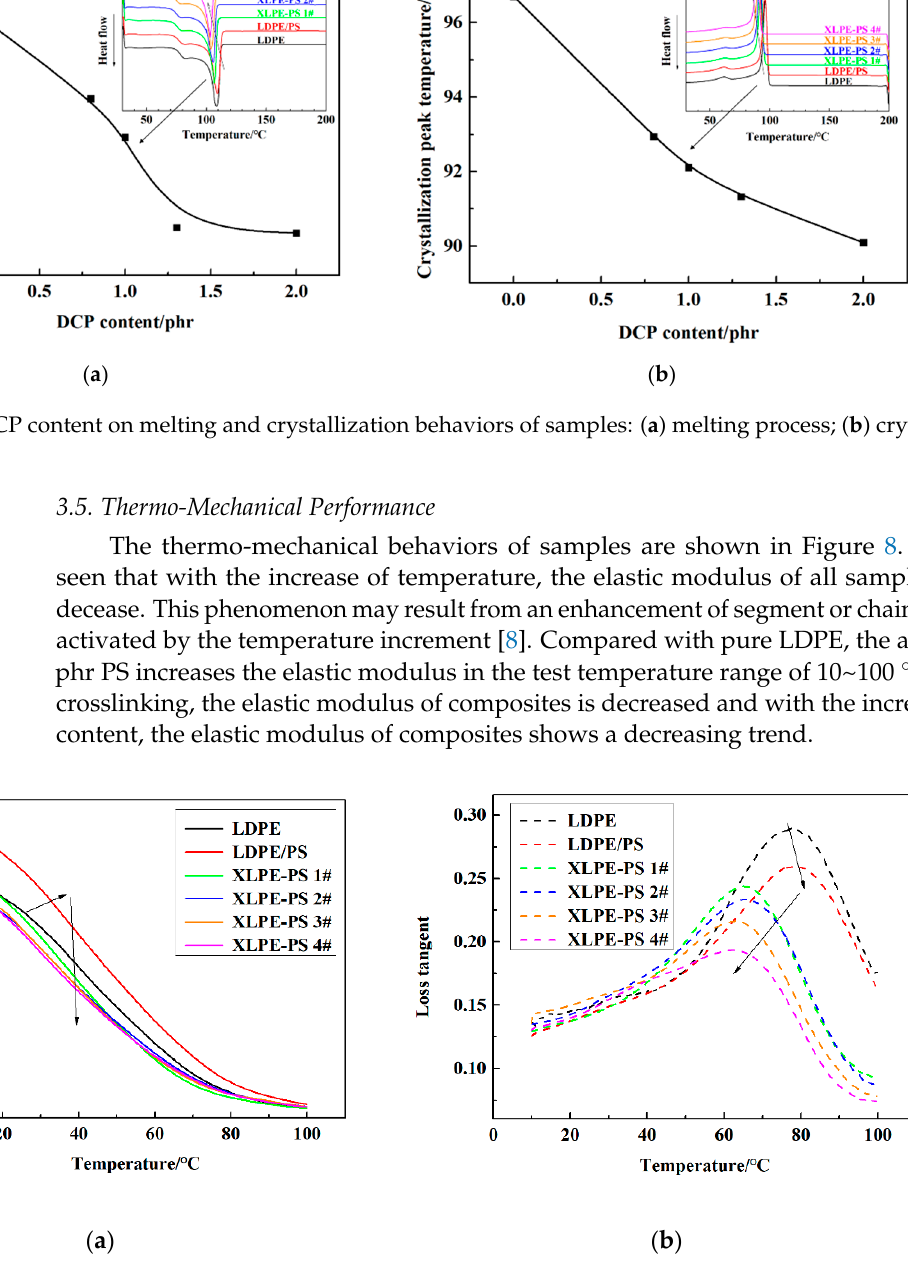
Figure 7. Effects of DCP content on melting and crystallization behaviors of samples: ( a ) melting process; ( b ) crystallization process.